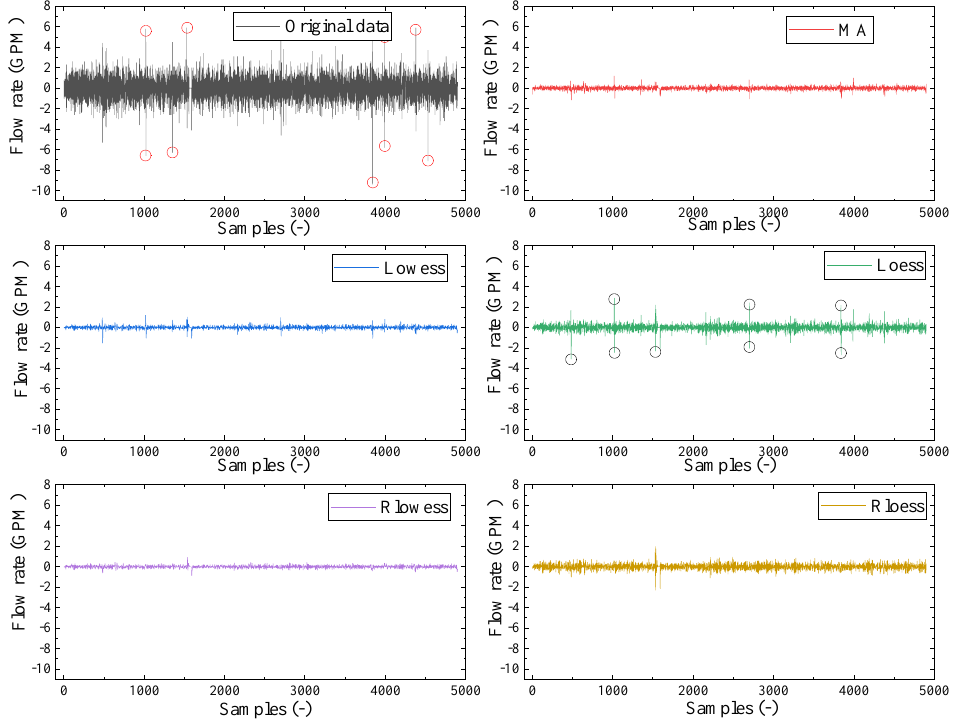
Figure 4. The data fluctuation of the cooling water flow sensor optimized by different methods when the smoothing level is level 2.